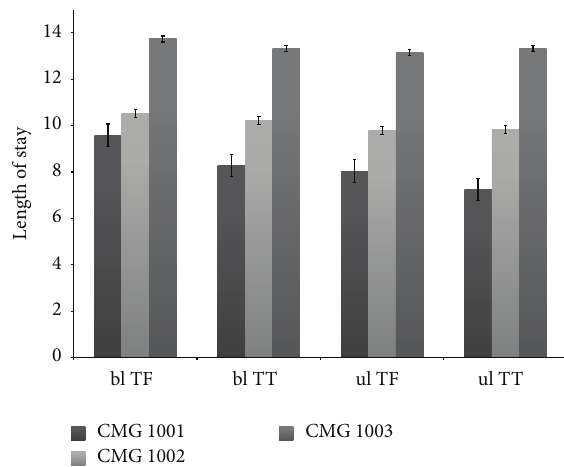
Figure 1: Length of stay by amputation levels for case mix group after adjustment of function. ul = unilateral, bl = bilateral, TF = transfemoral, and TT = transtibial.